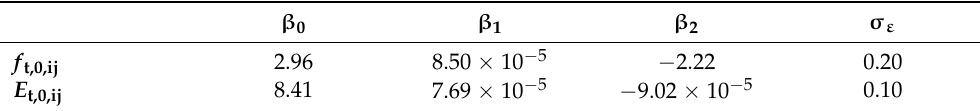
Table 5. Coefficients and standard deviations of the error term for the regression model in Equation (4) for Y = { f t,0,ij ; E t,0,ij } in (MPa); from Fink et al. [26]. β 0 β 1 β 2 f t,0,ij